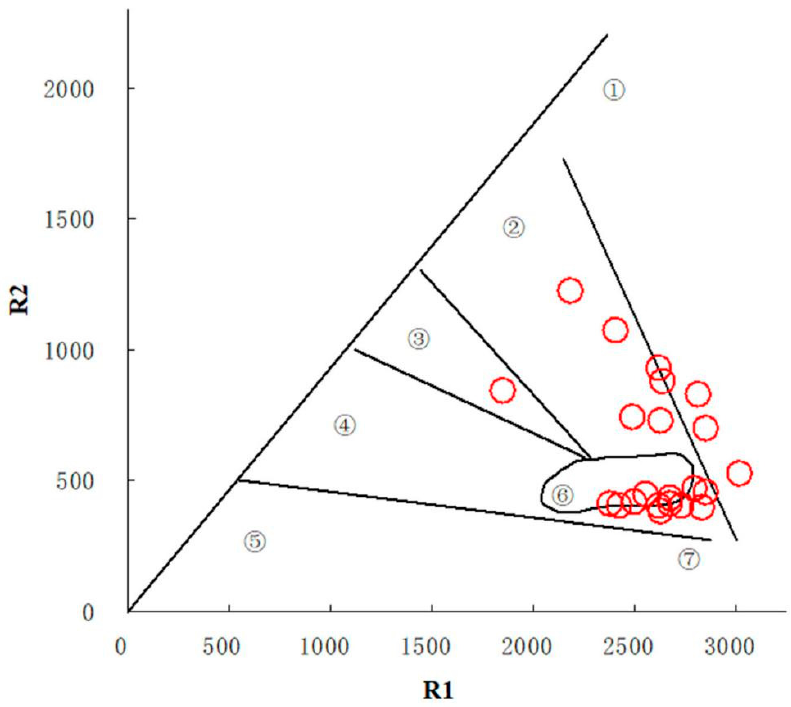
Figure 9. R1–R2 diagram for the Dahongliutan pluton (according to Batchelor, et al. [59]). ① R1: 4Si-11(Na + K) − 2(Fe + Ti); R2: 6Ca + 2Mg + Al; Mantle anorthosite granite; ② Destructive active plate edge (before plate collision) granite; ③ Granite from the uplift stage after plate collision; ④ Late tectonic granite; ⑤ Non-orogenic A-type granite; ⑥ Syn-collisional (S-type) granite; ⑦ Post-orogenic A-type granite.